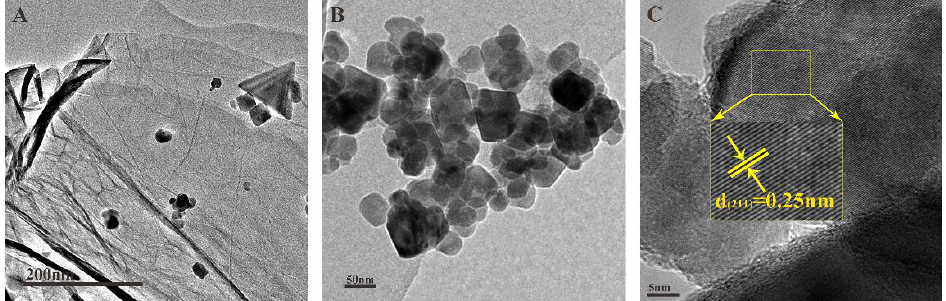
Figure 3. TEM image of CuFe 2 O 4 /NG samples ( A , B ) and HRTEM image of CuFe 2 O 4 /NG sample ( C ).